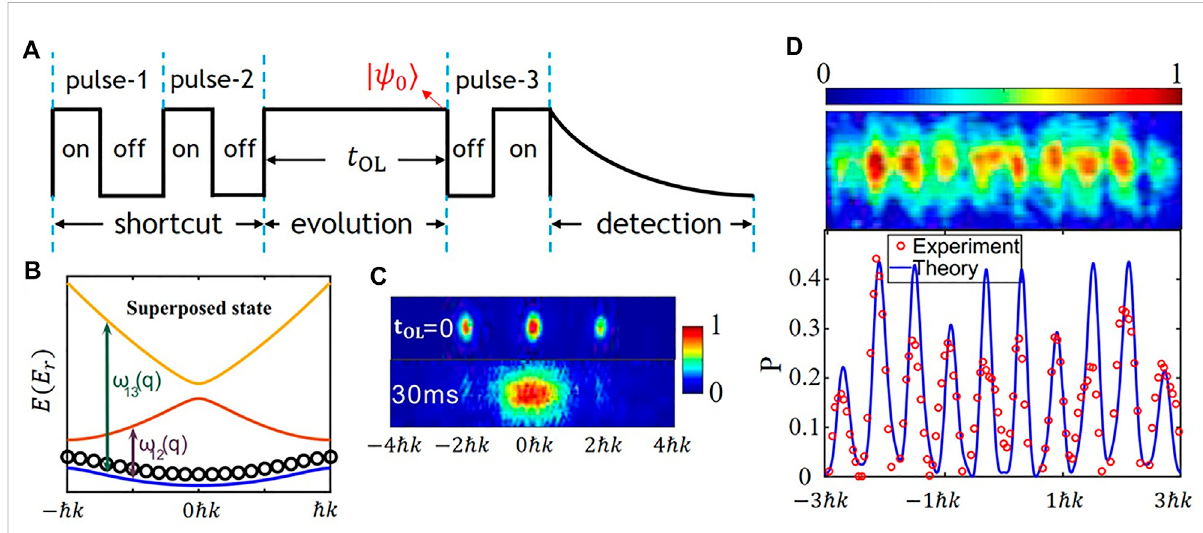
FIGURE 5 (A) Time sequence: after the fi rst two pulses and the30 ms holding time in the optical lattice, the state becomes the superposition of theBloch states inS-bandwith quasi-momentumtaking thevalues throughout the fi rstBrillouinzone, denotedas | ψ (0) 〉 . (B) The superpositionofBlochstates of S-band spreading the whole S-band. (C) The comparison of the experimental results between t OL = 0 ms and t OL = 30 ms. These results are obtained after the sequence in (A) but without pulse-3. (D) Patterns with ten main peaks for the experimental measurements (the red circles) and the theoretical curves (the solid blue line).